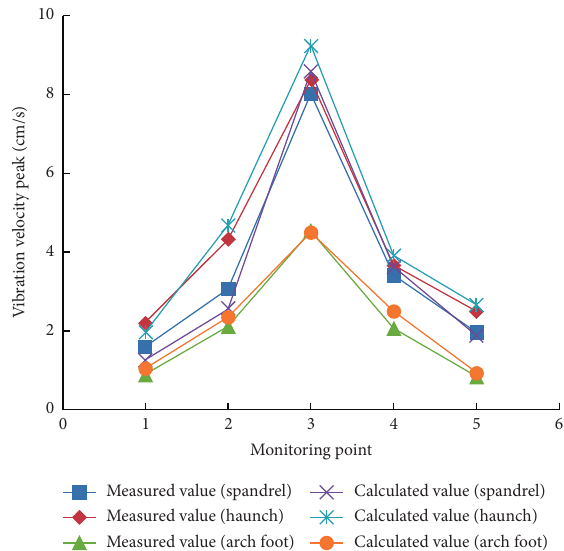
Figure 11: Variation curve of radial vibration velocity peak at different monitoring